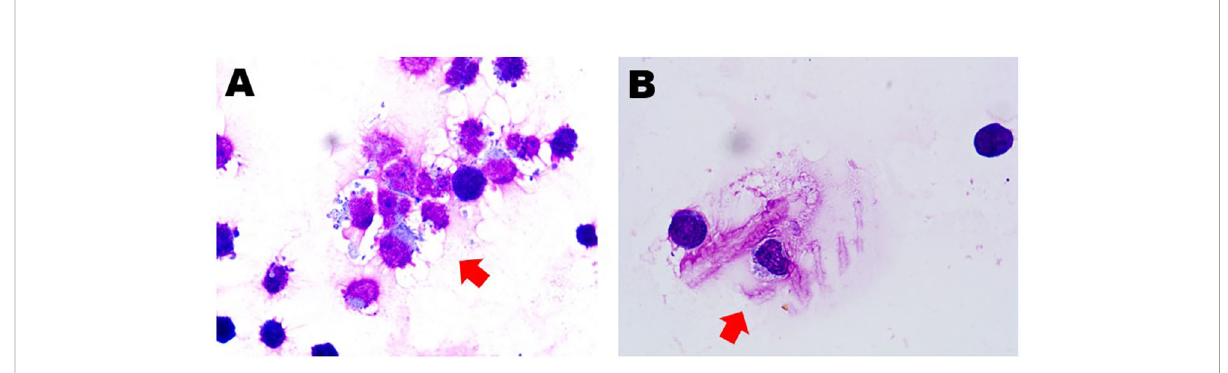
FIGURE 2 Cerebrospinal fl uid smear showed the presence of abnormal plasma cells (red arrows) before (A) and after (B) salvage